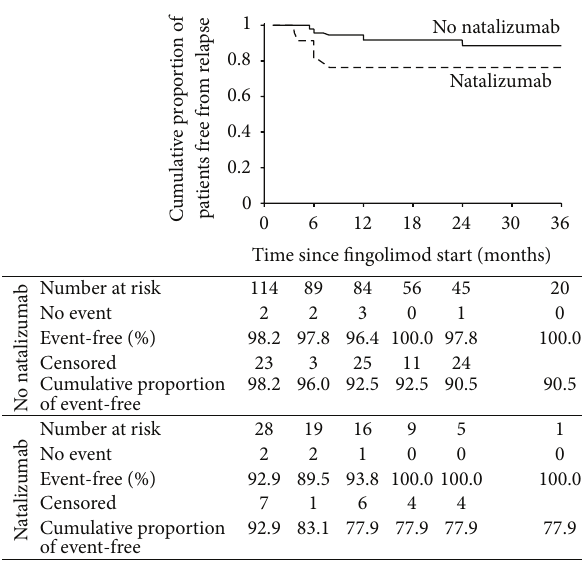
Figure 2: Kaplan-Meyer plot of cumulative proportion of patients remaining free from relapse by prior exposure to natalizumab over time from start of fingolimod